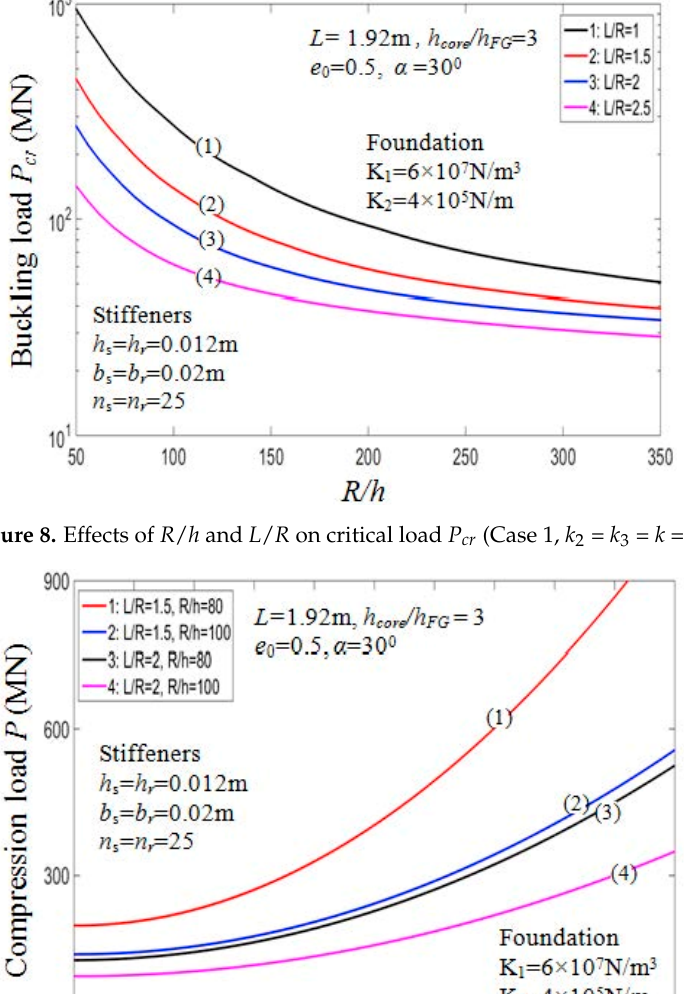
P for different values of volume fraction indexes. cr